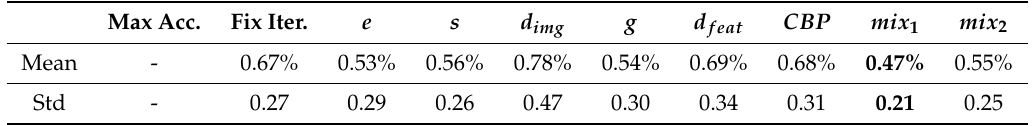
Table 2. Mean and standard deviation of the difference between the accuracy obtained with the use of a validation set and the proposed measures on the MNIST test set.